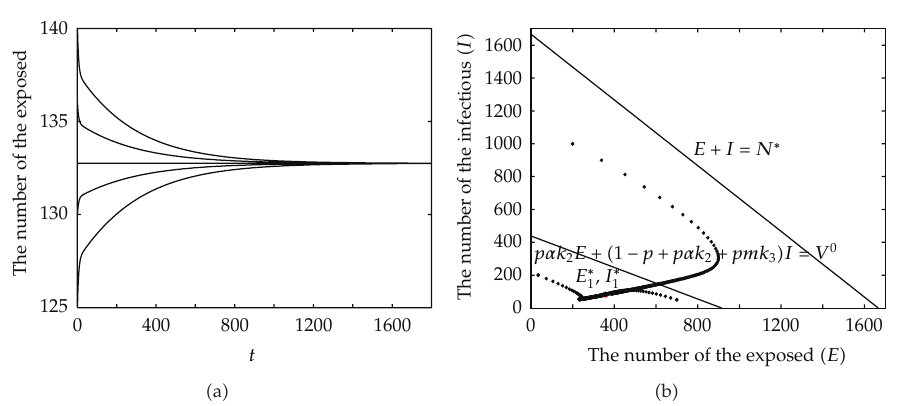
Figure 1: The stability and the attraction of the endemic equilibrium of (cid:2) 3.1 (cid:3) : (cid:2) a (cid:3) the endemic equilibrium and its stability and (cid:2) b (cid:3) the attraction